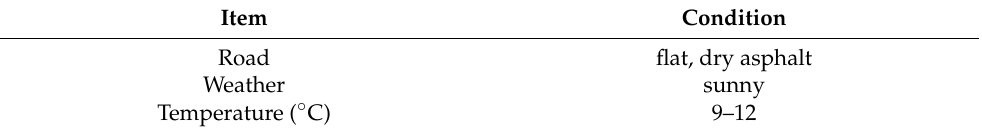
Table 5. The environmental